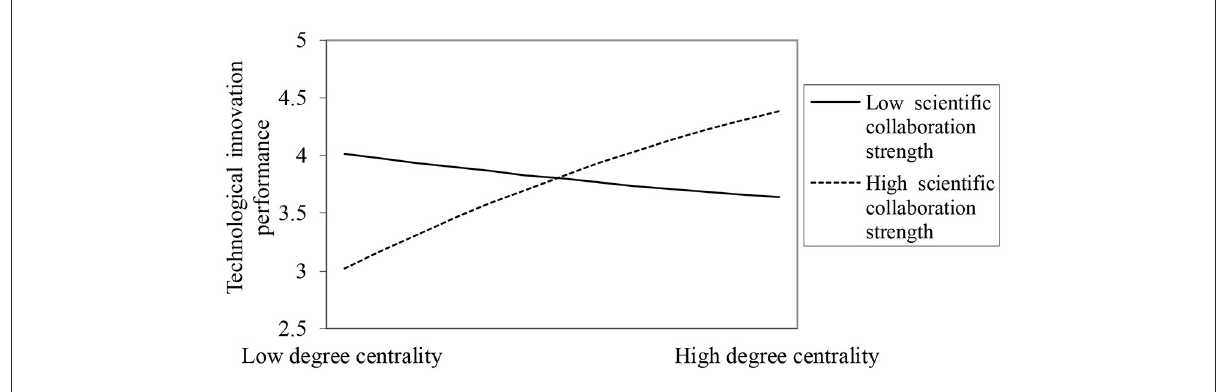
FIGURE3 The moderating effects of scientific collaboration